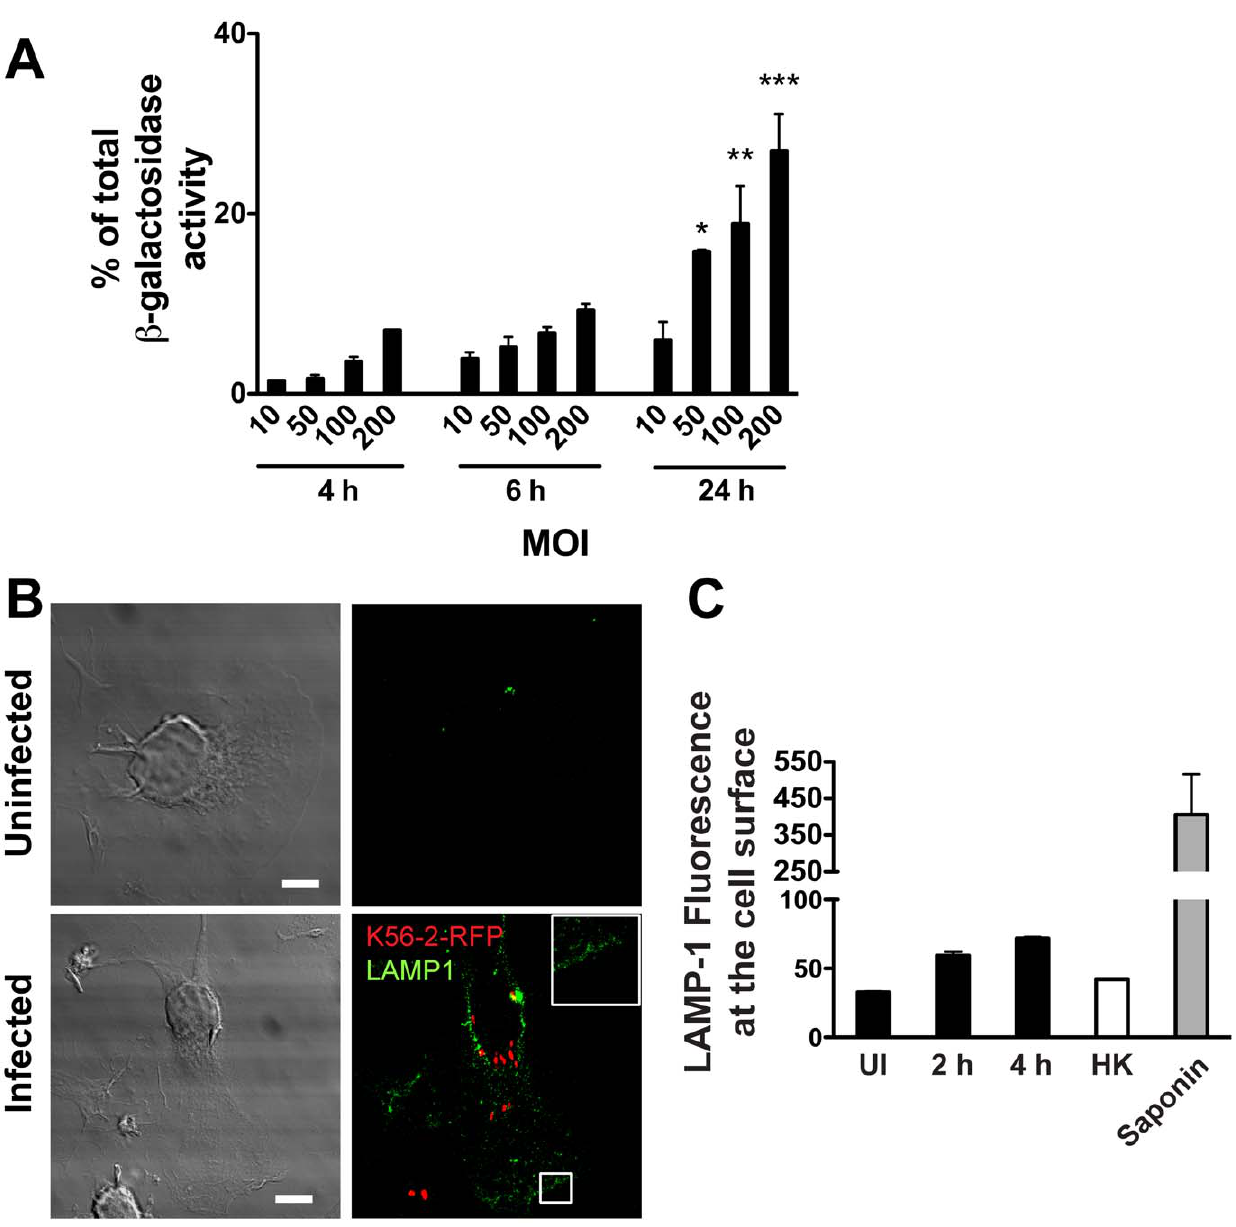
Figure 3. B.cenocepacia infection induces plasma membrane damage. Graphs represent mean 6 SEM from three independent experiments. A. Macrophages were infected with B. cenocepacia at different MOI for 1 h and then treated with gentamicin to eliminate extracellular bacteria. The b -galactosidase activity was quantified from supernatants of infected macrophages at 4, 6 and 24 h post-infection. * p # 0.05; ** p # 0.01 and *** p # 0.001 values for MOI of 10 at 24 h post-infection. B. Macrophages were infected with B. cenocepacia K56-2-RFP (red) for 4 h. Unpermeabilized cells were fixed and stained with anti-LAMP-1 antibodies (green). Representative confocal z slice is shown. Inset is higher magnification of the boxed area. Scale bars are 10 m m. C. Macrophages were infected with B. cenocepacia K56-2 for 2 or 4 h. The cells were stained without permeabilization with anti-LAMP-1 antibodies (green) and analyzed by flow cytometry. The graph shows the mean intensity of fluorescence (MIF) of LAMP1 in the cell surface. UI, uninfected macrophages; HK, macrophages infected with heat-killed bacteria; saponin, macrophages permeabilized with saponin. doi:10.1371/journal.pone.0041726.g003 autocatalytically cleaved into mature ZmpA-cyaA’ or ZmpB-cyaA’ (79- and 78-kDa, respectively) and degradation products. Mature